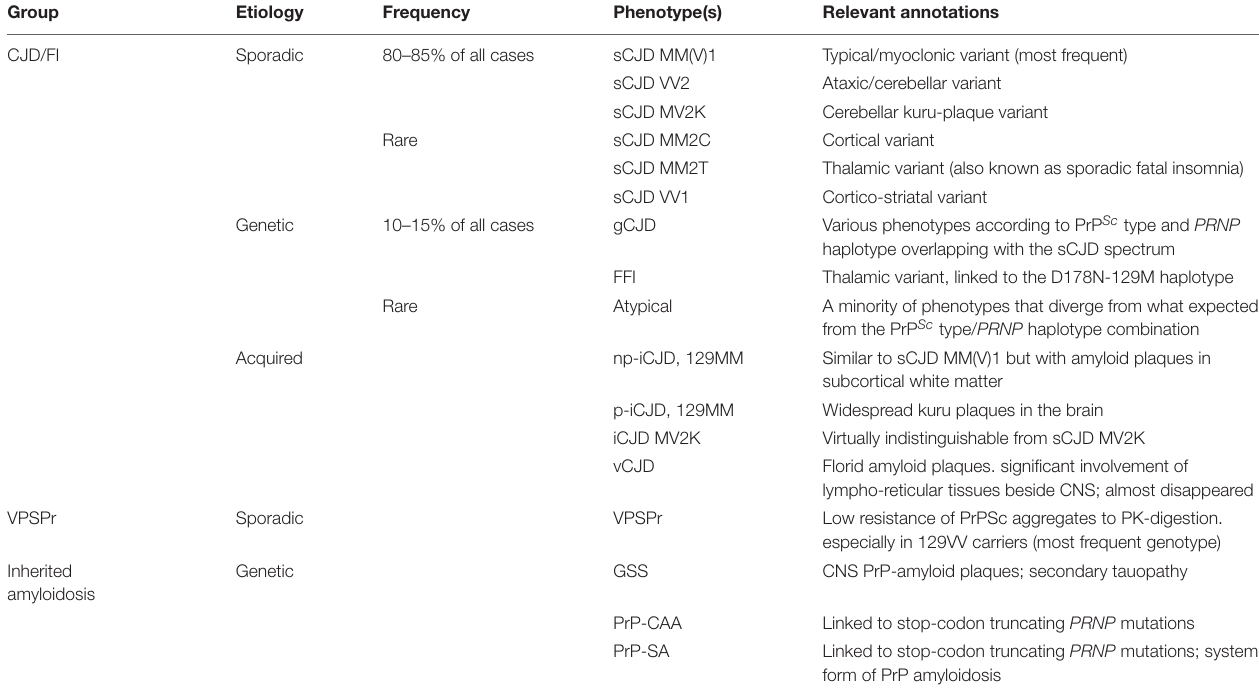
TABLE 1 | Phenotypic spectrum of human prion disease.